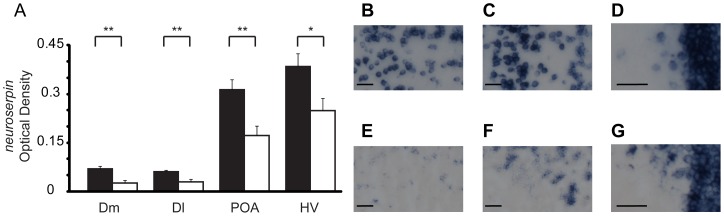

Neuroserpin expression in male-exposed females.(A) Significant differences in neuroserpin expression of male-exposed females (large/large, large/small, small/small) between groups of high (black) and low (white) preference score females measured in Dm, Dl, POA, and HV. Bars represent standard error. **, p<0.01; *, p<0.05. (B–D) are representative images of a high-preference female (preference score  = 0.4) for Dm, Dl, POA, respectively. (E–F) are representative images of a low-preference female (preference score  = −0.91) for Dm, Dl, POA, respectively. Scale bar is 25 microns.